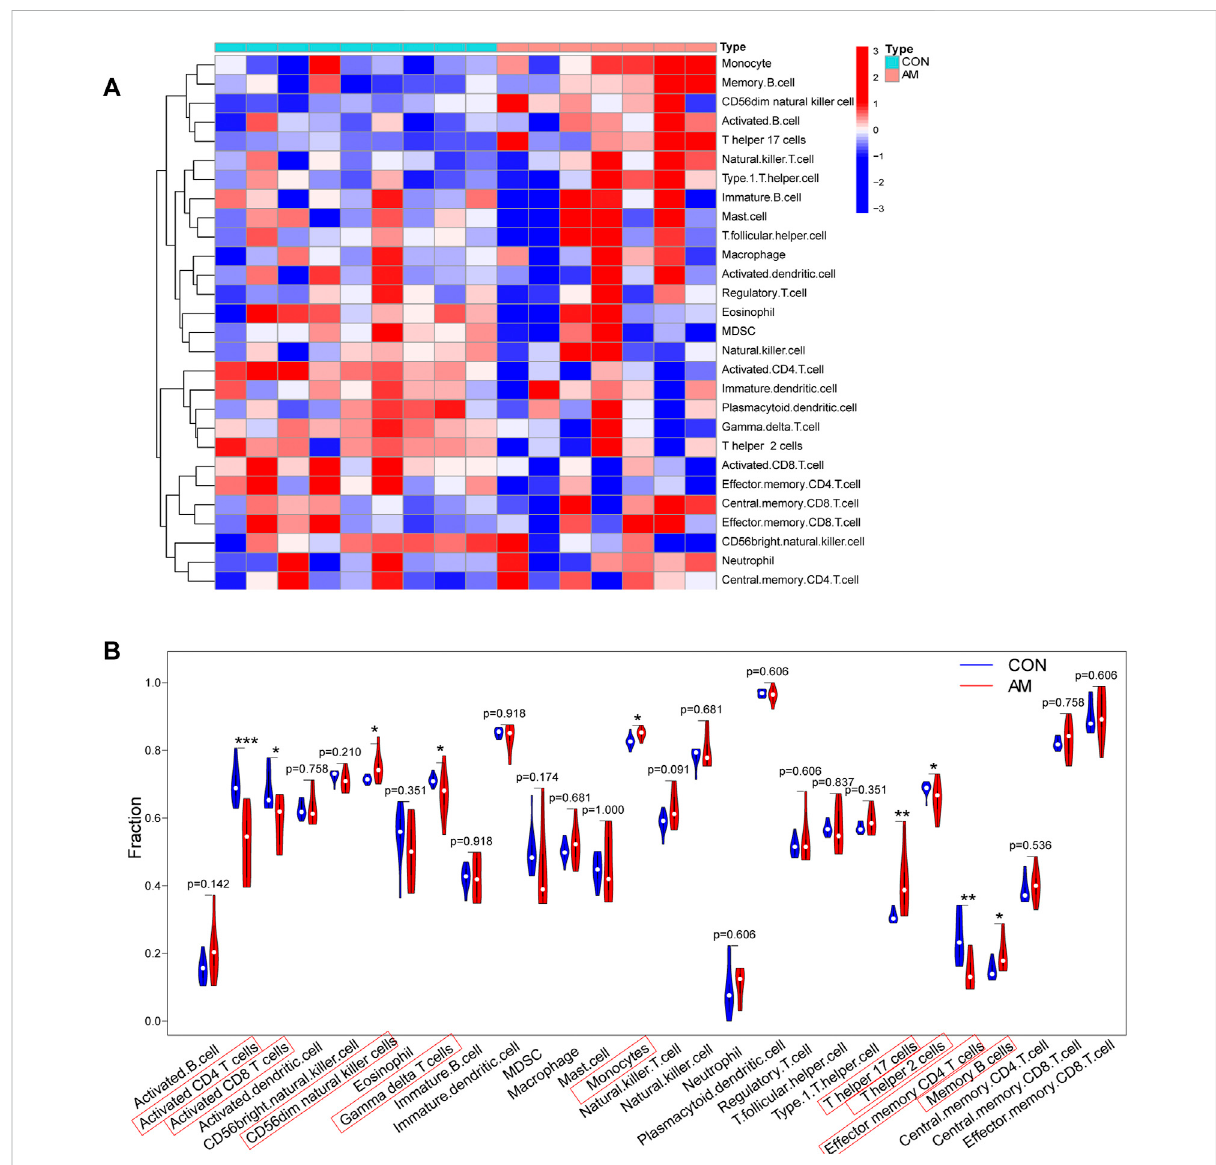
FIGURE 6 Immunecellin fi ltrationanalysisusingssGSEA. (A) Heatmapofthedistributionof28immunecellsintheadenomyosisandcontrolgroup. (B) The violin plot of the different distribution of 28 immune cells between the adenomyosis and control groups (* p < 0.05, ** p < 0.01, *** p < 0.001, **** p < 0.0001). SsGSEA: Single-sample Gene Set Enrichment Analysis.